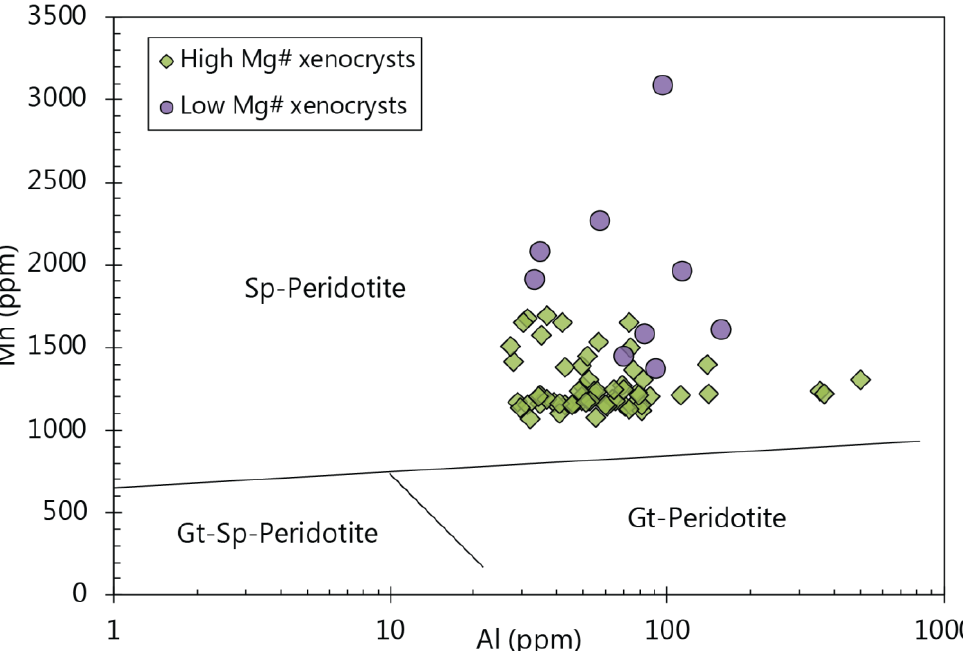
Figure 5. Olivine xenocrysts’ Mn plotted against Al, with peridotite field from De Hoog et al. [52]. Both low and high Mg# xenocrysts plot in the spinel peridotite field, with the large variation in Mn and Al concentrations, were likely the result of metasomatism.